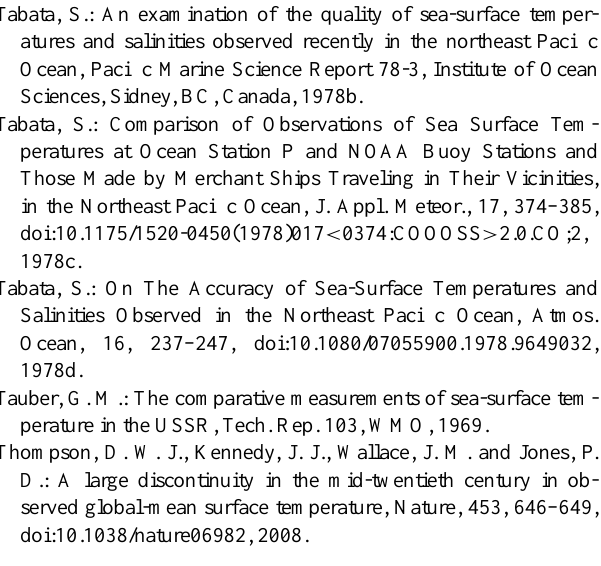
Tabata, S.: On The Accuracy of Sea-Surface Temperatures and Salinities Observed in the Northeast Pacific Ocean,